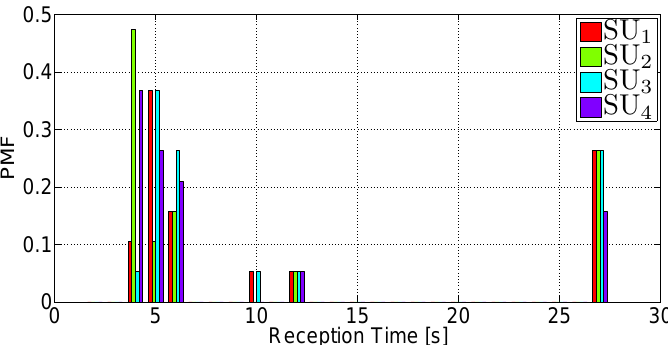
Figure 25. PMF of the archive reception time in Scenario 3.